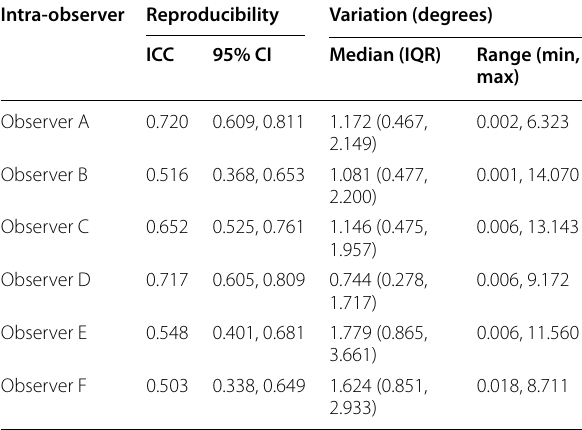
ICC intraclass correlation efficient, CI confidence interval, IQR interquartile